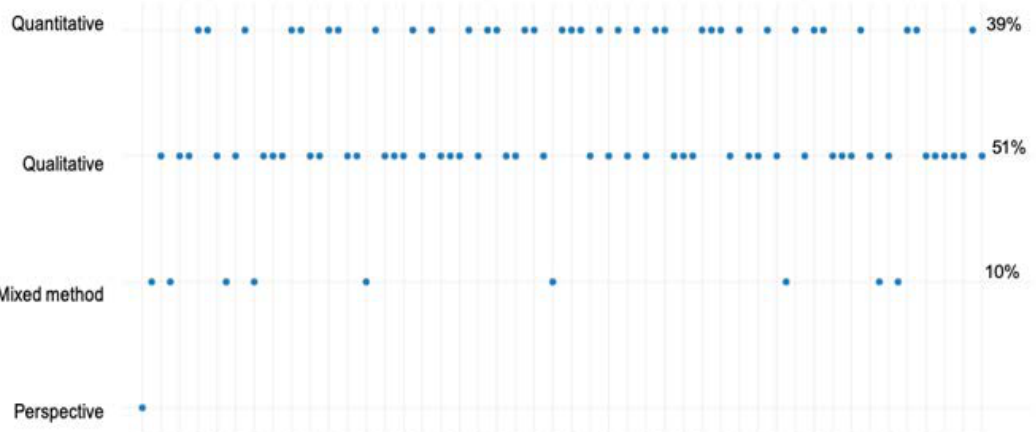
Figure 5 . Perspectives of educational research used in